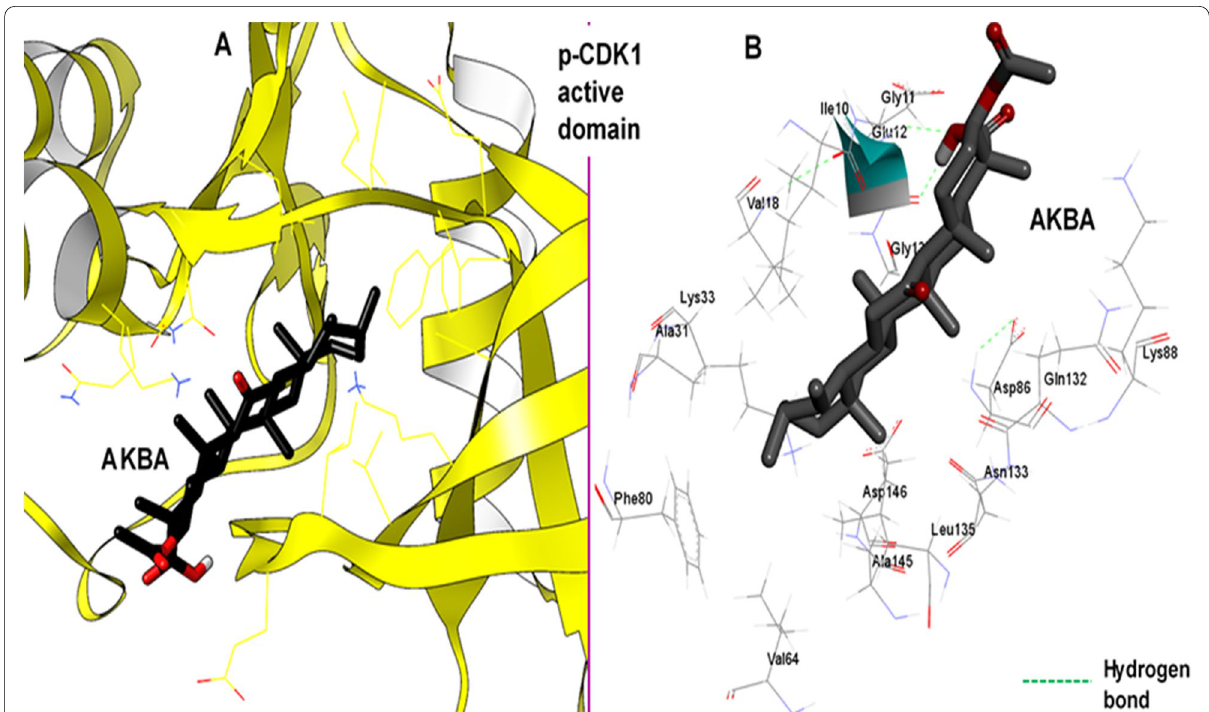
Fig. 5 Interaction mechanisms of AKBA at the active domain of p-CDK1. A Binding orientation of AKBA at the target site. B Crucial residues that complementarily interact with AKBA at the p-CDK1 binding domain